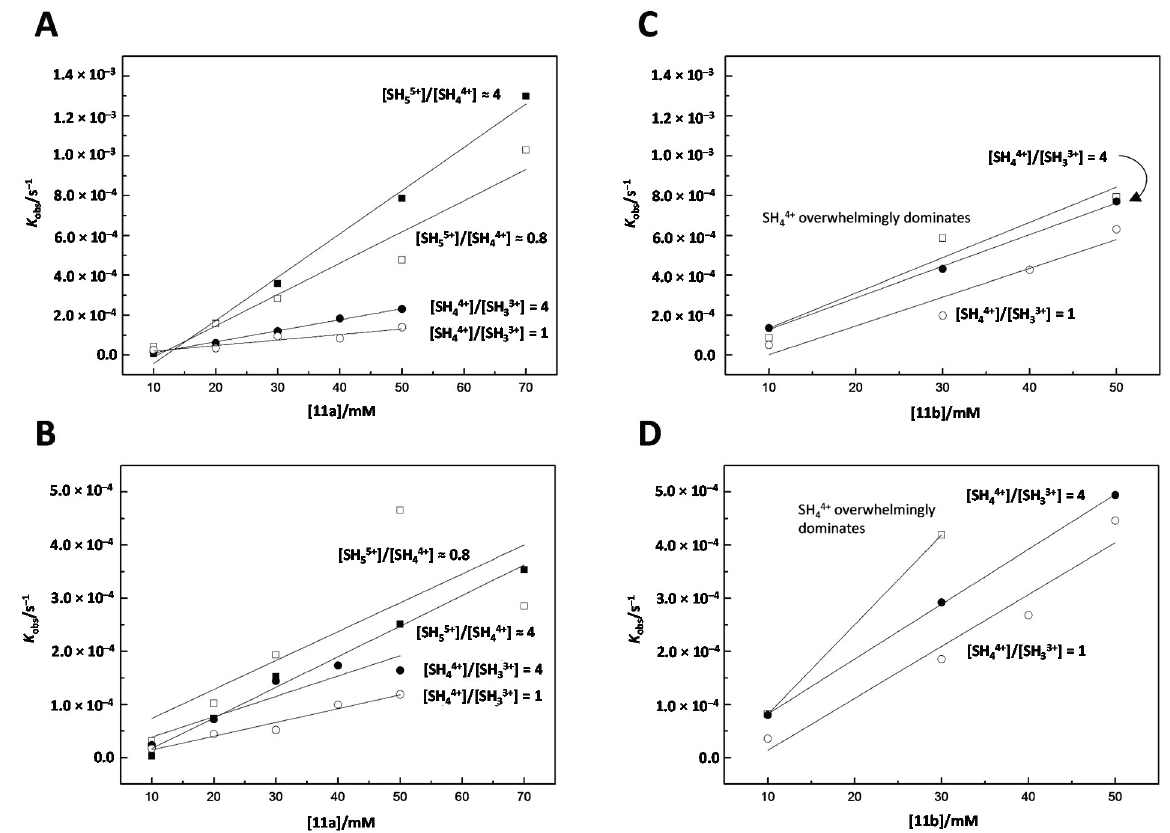
Figure 3. Observed pseudo first-order rate constants for ( A ) cleavage and ( B ) isomerization of UpU as a function of [ 11a ] and ( C ) cleavage and ( D ) isomerization of UpU as a function of [ 11b ]; T = 90 °C, I (NaClO 4 ) = 1.0 mol·L − 1 . The catalyst ( 11a or 11b ) was